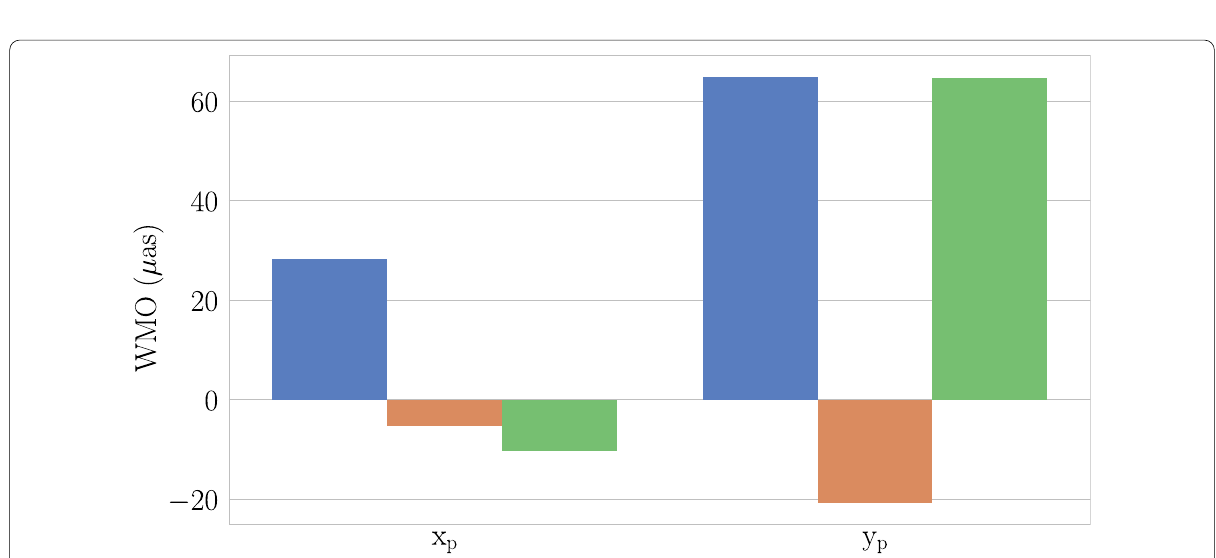
Fig. 14 Polar motion (x p , y p ) weighted mean offsets (WMO) w.r.t. IGS PM products for sol‑V (blue), sol‑VG (orange), and sol‑VV